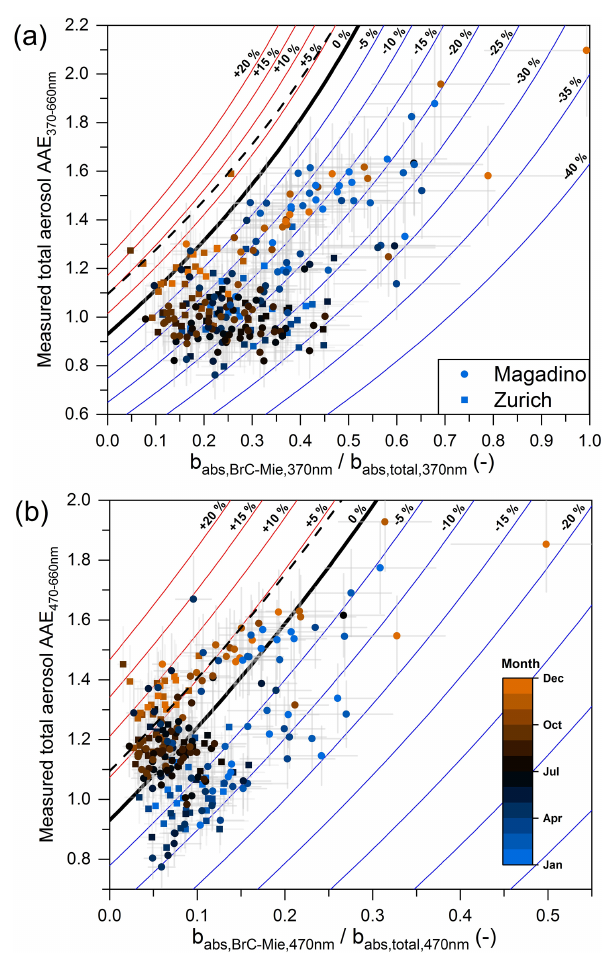
Figure 8. Total measured aerosol AAE (referenced to 660nm) vs. the ratio of calculated BrC absorption to measured total absorption at 370nm (a) and 470nm (b) , showing the effect of BrC–BC in- teractions on the aerosol absorption profile. Uncertainty in the ra- tio C 370nm /C 660nm used for the calibration of AE33 attenuation measurements translates into vertical error bars, while horizontal error bars include uncertainties in AE33 absolute calibration coeffi- cients C 370nm and in the BrC absorption at 370nm from Mie cal- culations without contingency for errors associated with assuming homogeneous spheres. The isopleths indicate the extent of total ab- sorption under- or overestimation on the basis of a predicted absorp- tion by BC and BrC, where (apparent) lensing by transparent BC coatings (using AAE bareBC = 0 . 93) is assumed to be wavelength- independent (isopleth = (measured – predicted) / predicted). The dashed line, which corresponds to additive absorption if transparent shell lensing was increasing with decreasing wavelength (by 10% or 6%, from 660 to 370nm or 470nm, respectively), serves to il- lustrate sensitivity of the closure to spectral extrapolation of trans- parent shell lensing. Overpredictions (negative isopleths) provide indication for a filter-based lensing suppression